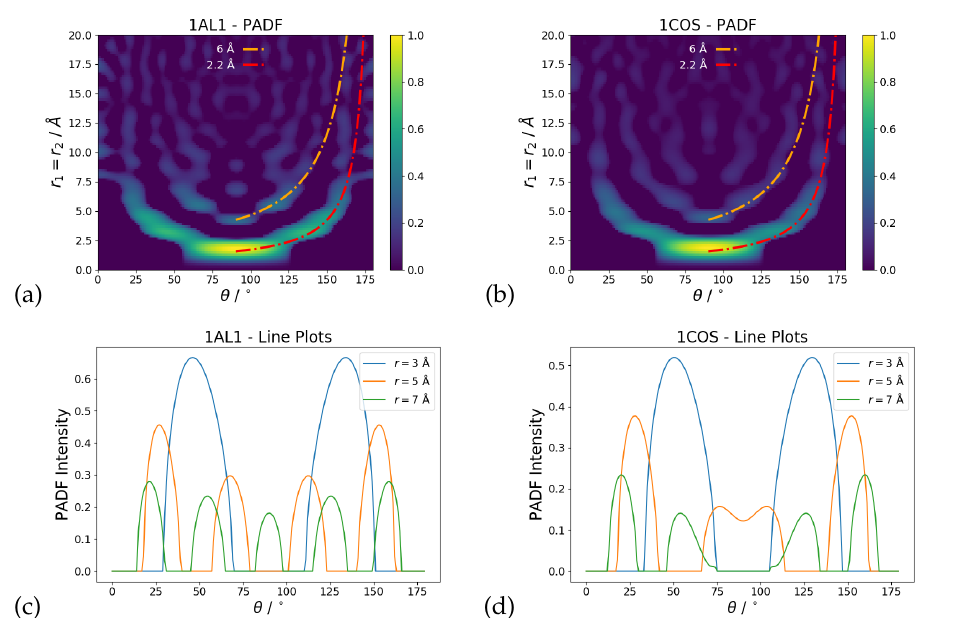
Figure 6. PADF correlation of ( a ) a single helix protein (1AL1) and ( b ) a three-helix bundle (1COS), generated from the q -space correlation function C ( q , q (cid:48) , θ ) (see Equation (2)). The intensity within these plots is clipped to show only positive correlation, scaled to the power of 0.25 to flatten peak intensity. This qualitatively shows regions of correlation, where we might expect to see particular arrangements of atoms, but removes the relative intensity of finding such arrangements. Plots ( c , d ) show PADF intensity line plots for selected distances as a function of θ for 1AL1 and 1COS